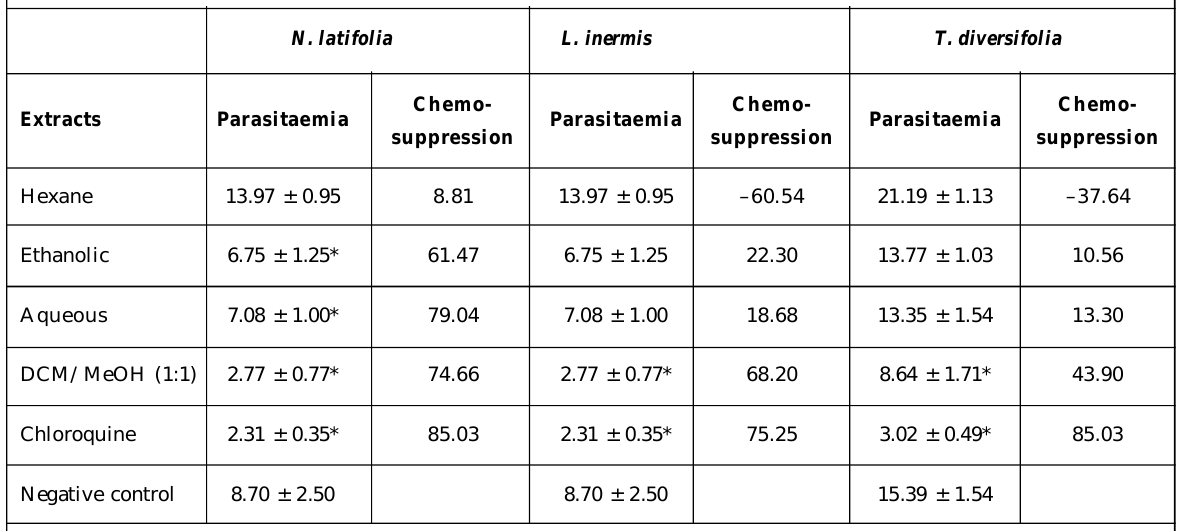
Table 2: In vivo suppressive antimalarial screening of Tithonia diversifolia, Lawsonia inermis and Nauclea latifolia at 250 mg/kg against Plasmodium berghei infected mice at day 4 post-infection